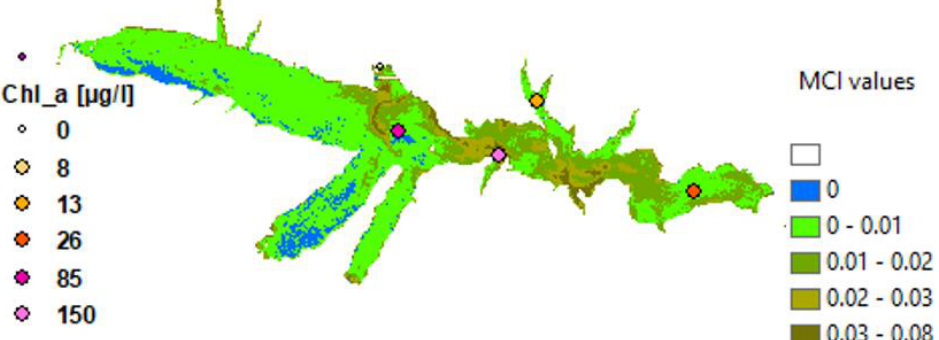
Figure 8. MCI map for day 27 February 2017. Circles correspond to the sites where ground samples were collected.